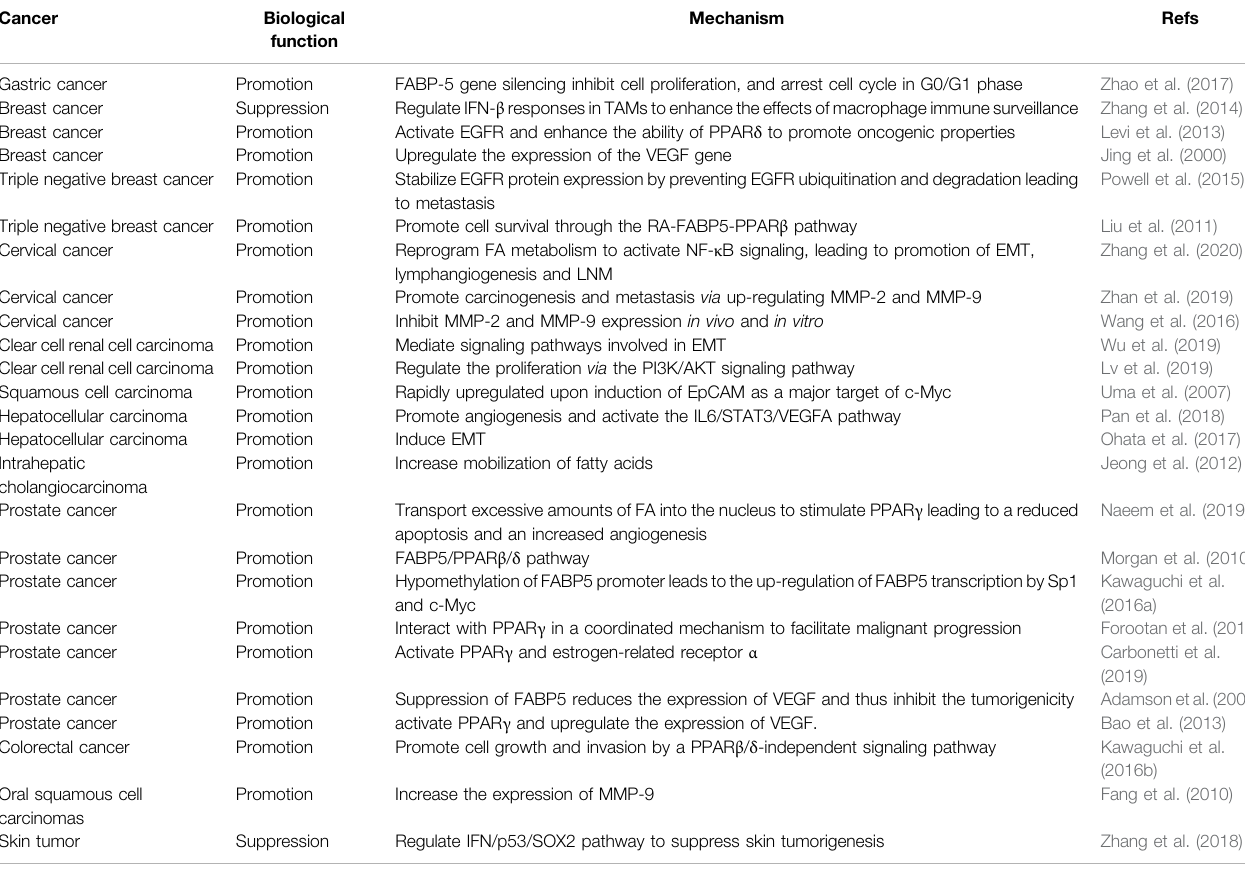
TABLE 2 | The roles and mechanisms of FABP5 in various types of cancer.